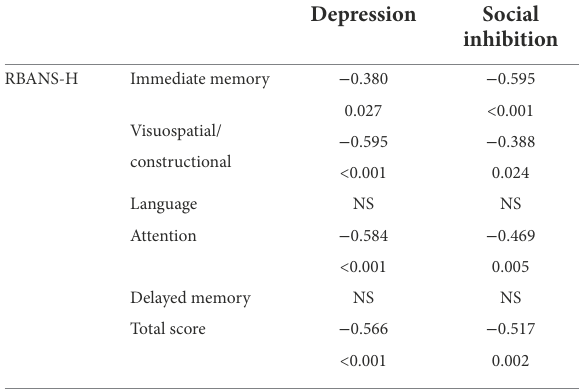
TABLE 3 Correlations between the RBANS-H and the psychological factors depression and social inhibition. Depression Social